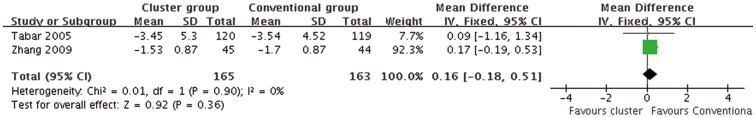
Meta-analysis of the RCTs comparing symptom scores between cluster group and conventional group.